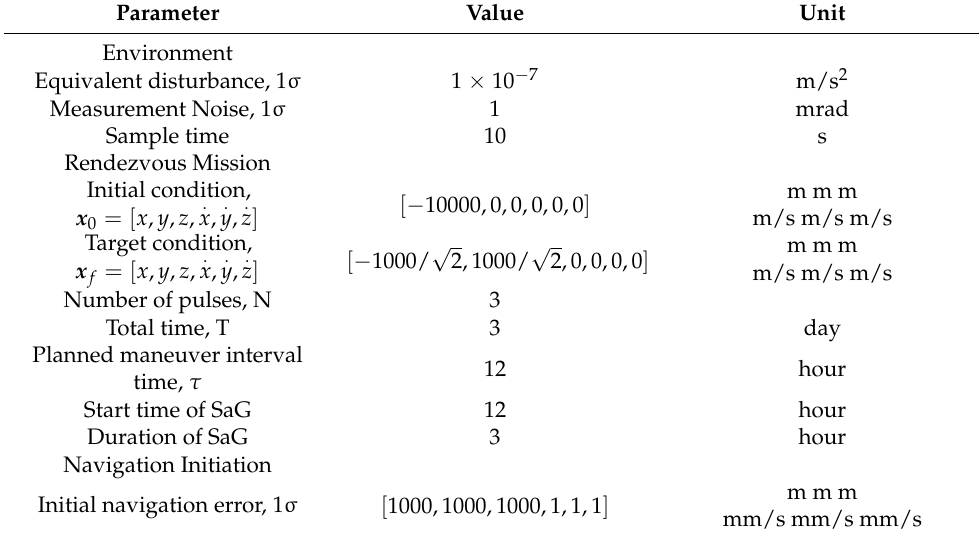
Table 3. Simulation